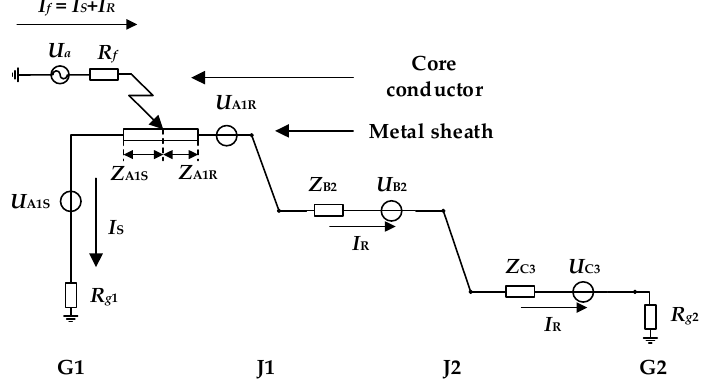
Figure 4. The equivalent circuit of sheath current when a short circuit fault occurs in section A1. The expressions of I S and I R are shown in (7) and (8), where Z A 1 S represents the equivalent impedance of the metal sheath section from G1 to the fault position, and Z A 1 R represents the equivalent impedance of the metal sheath section from the fault position to J1. For the specific solution method of each parameter, see reference [23], and the position of the fault point can be calculated by the phase difference P (section) between I S and I R . For example, P (A1) represents the phase difference between I S and I R of A1 section, the sheath currents are measured at G1 and J1.